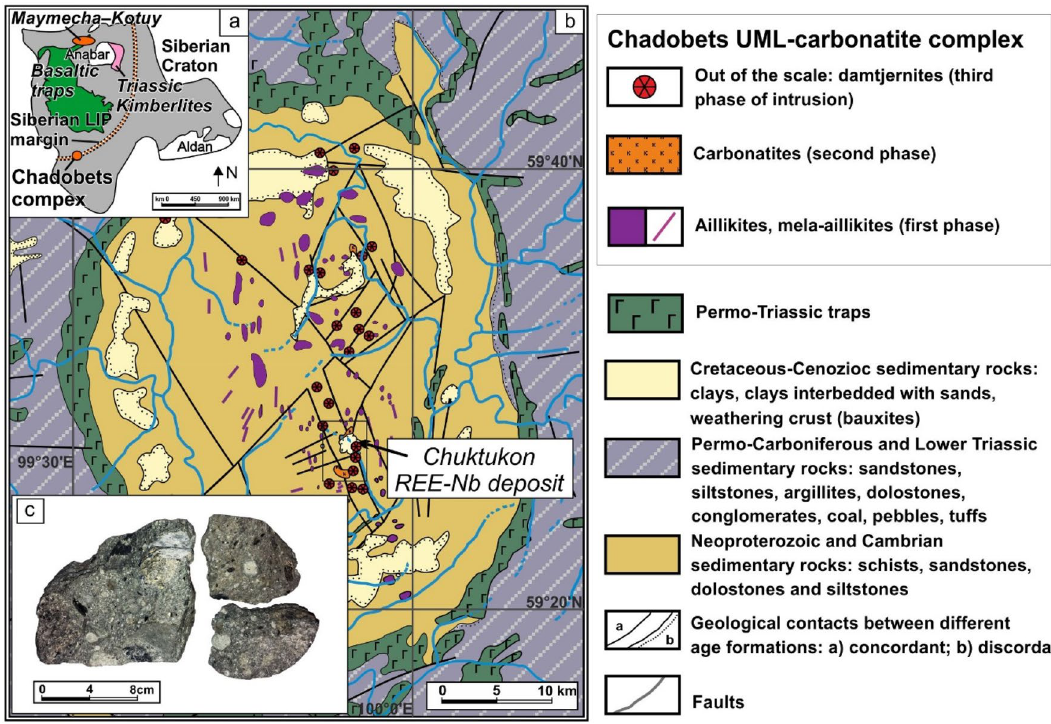
Figure 1. ( a ) Location of the Chadobets ultramafic lamprophyre (UML)–carbonatite complex within the Siberian Large Igneous Provence (LIP) 27 . ( b ) Geological scheme of the Chadobets alkaline complex 7,14 . ( c ) Samples of damtjernites from exploratory well (548–100.8 m). The figure was created using Corel Draw X4 software https:// www. corel draw. com/ en/ pages/ corel draw-